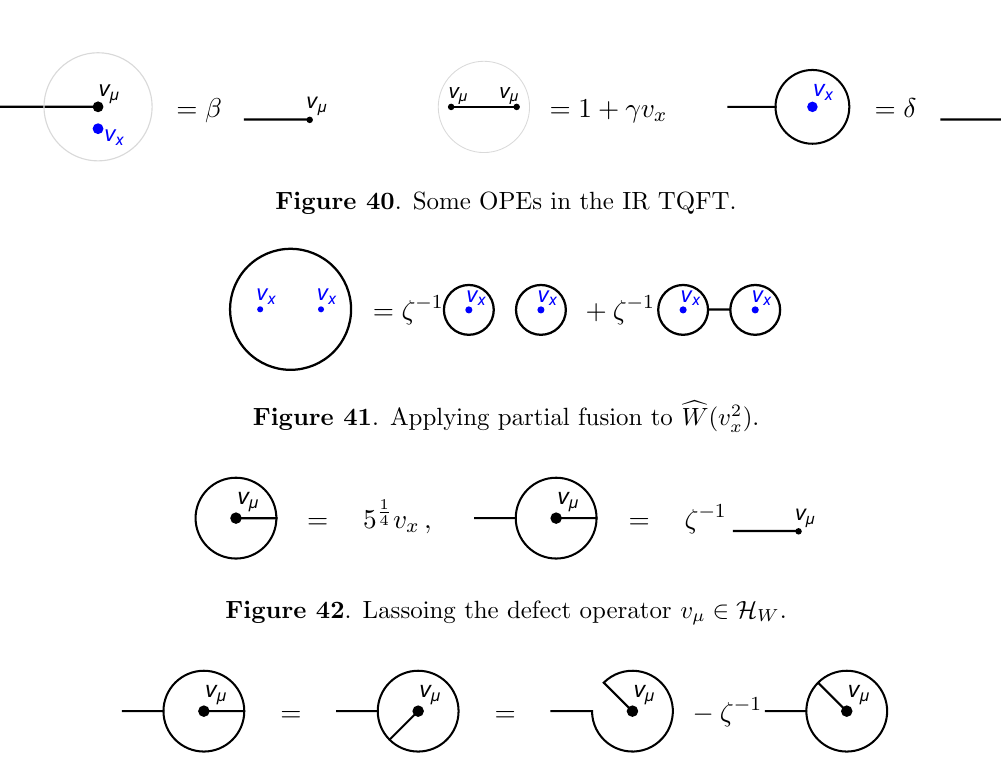
Figure 43 . Determining the lassoing of the defect operator v (cid:22) 2 H W